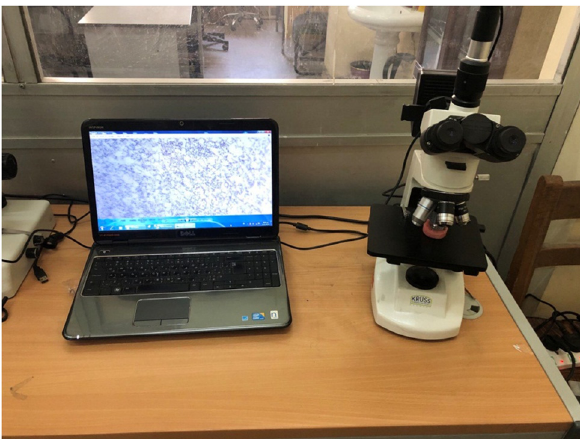
Figure 2: Optical microscope.